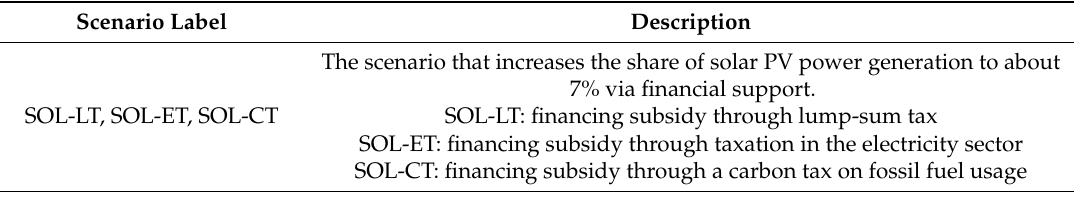
Table 5. Scenarios used in the